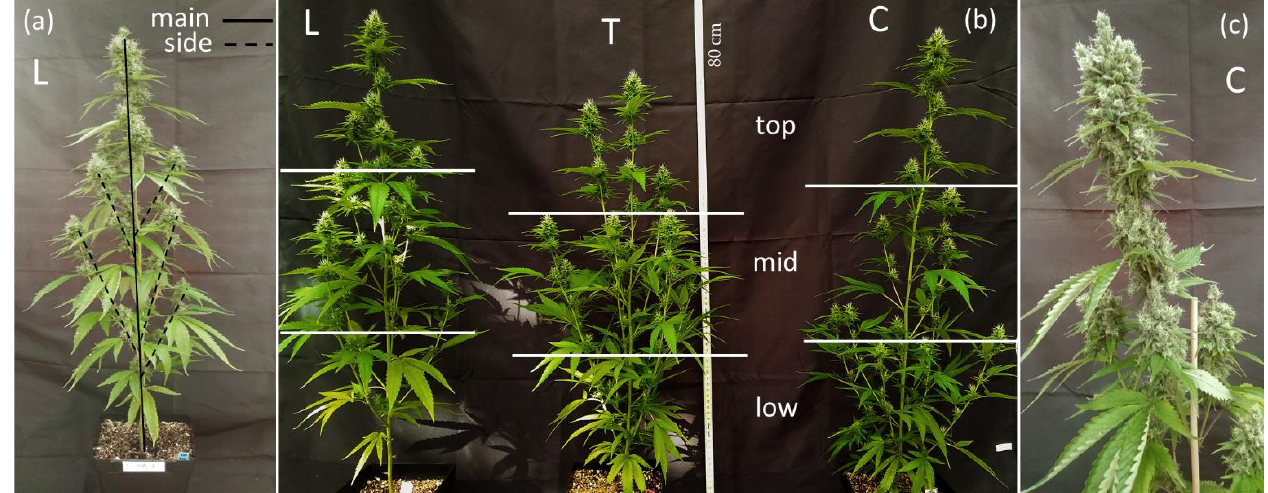
Figure 1. ( a ) Separation of main axis and side shoots in a lollipop (L) plant; ( b ) Plant architecture as modified by pruning techniques in plants at five weeks of flowering (65 DAP), shortly before the first harvest. Lollipop (L, left), topping at tenth node (T, center) and control (C, right). The horizontal lines show the separation of inflorescences into the three fractions (top, mid and low) based on each plant’s height ; ( c ) Main top inflorescence of a control plant at nine weeks of flowering (93 DAP).